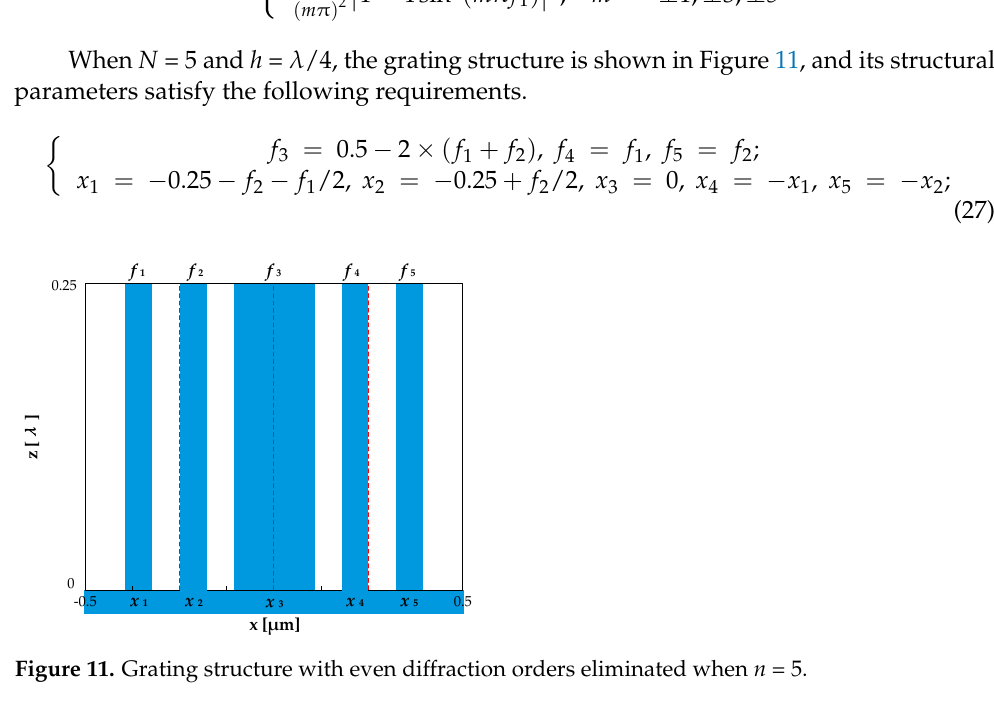
Figure 11. Grating structure with even diffraction orders eliminated when n = 5.